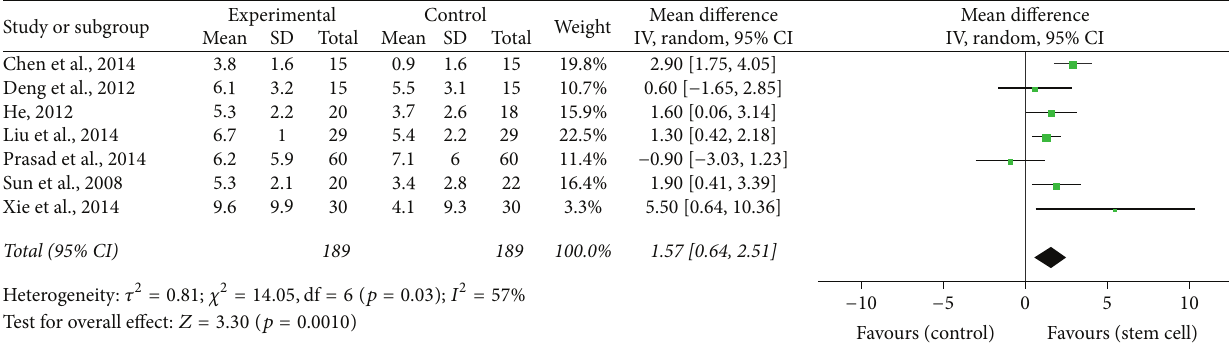
Heterogeneity: Test for overall effect: Z = 3.30 Figure 2: The effect size of NIHSS improvement across studies by